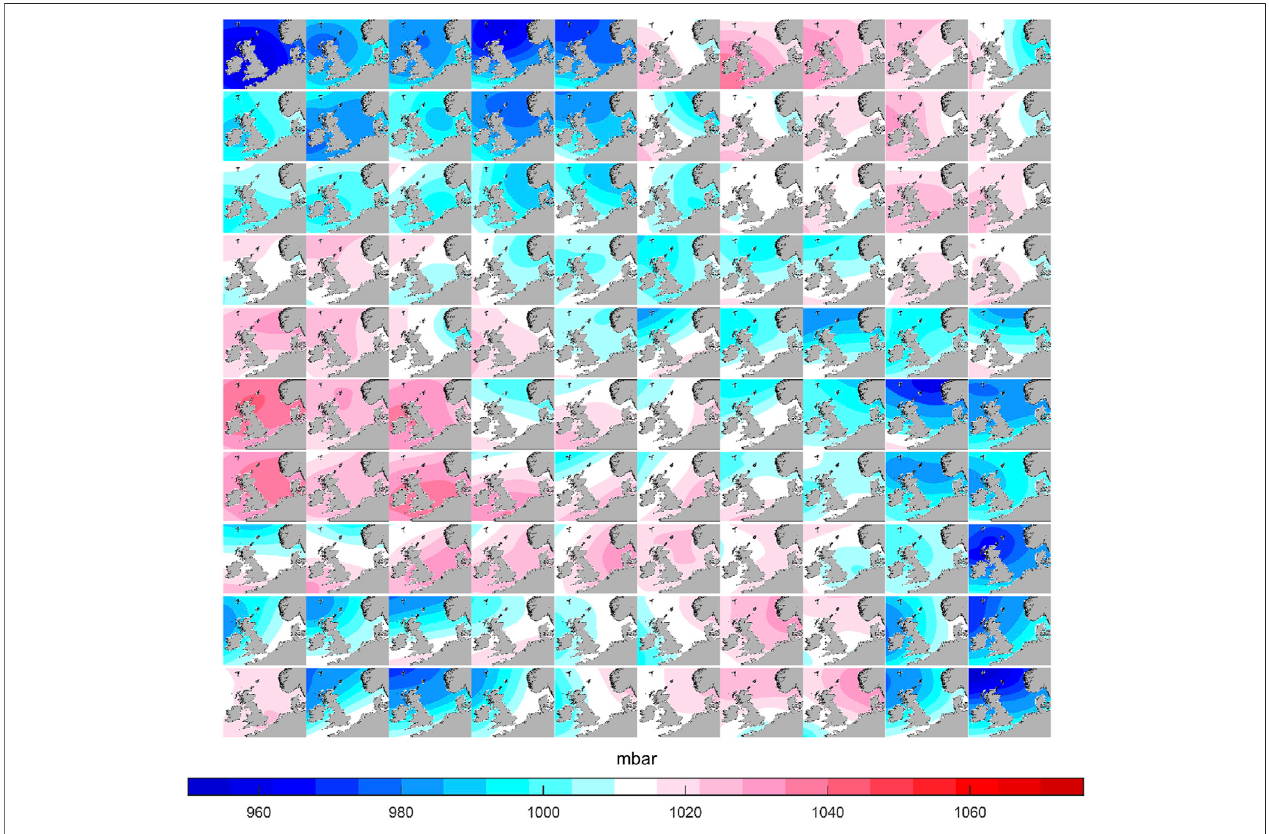
FIGURE 3 | The sea level atmospheric pressure fi elds associated with the weather types, derived from ERA5. Darker blue colors indicate intense low-pressure systems, dominated by a depression generally located in the northwestern area of the studied region. Deep red colors indicate situations of high pressure systems (i.e. anticyclones). Central panels of the lattice show weather types with less intense pressure